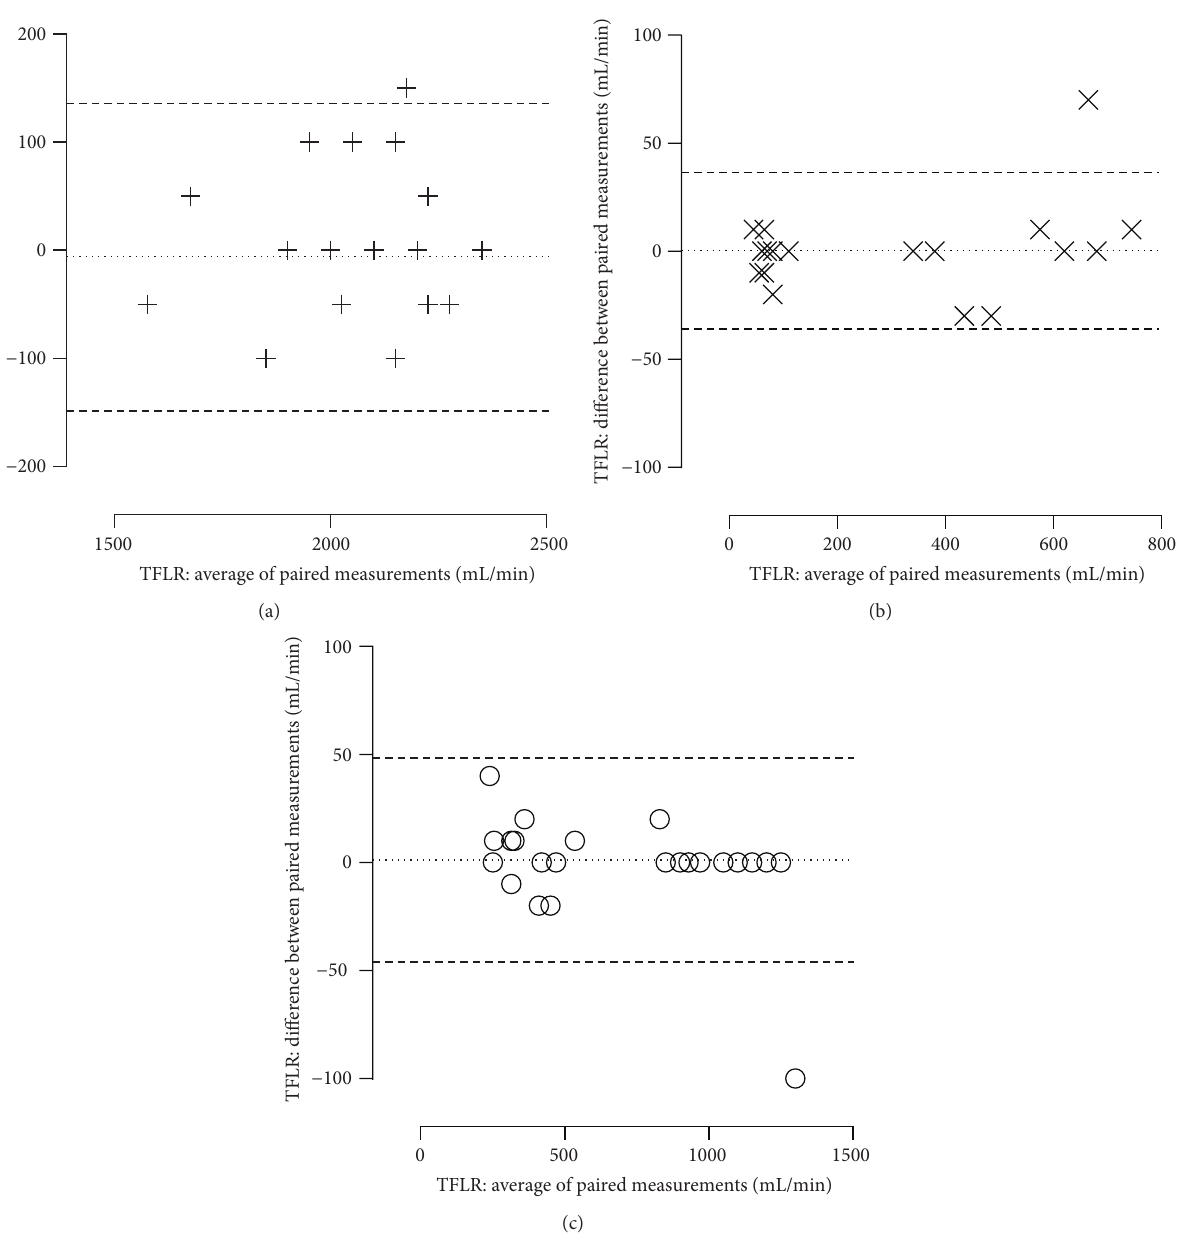
Figure 2: Bland-Altman plot of paired transfenestration leakage rates of Portex Blue Line Ultra (+), TRACOE twist ( × ), or R¨usch Traceofix ( I ) tracheostomy tubes. TFLR: transfenestration leakage rate.